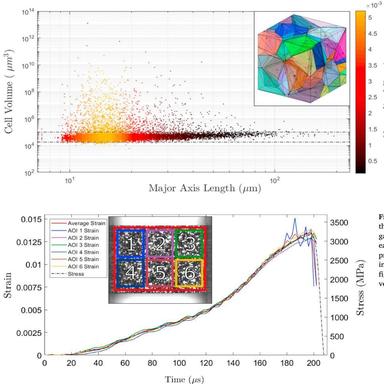
Log-log plot of Voronoi cell volume as a function of pore major axis length in AD85. Contour shows normalized density. Dashed lines indicate boundaries to the high frequency band where the majority of data points lie. The inset is a visualization of Voronoi tessellation where the red dots are seed points. (For interpretation of the references to color in this figure legend, the reader is referred to the Web version of this article.)